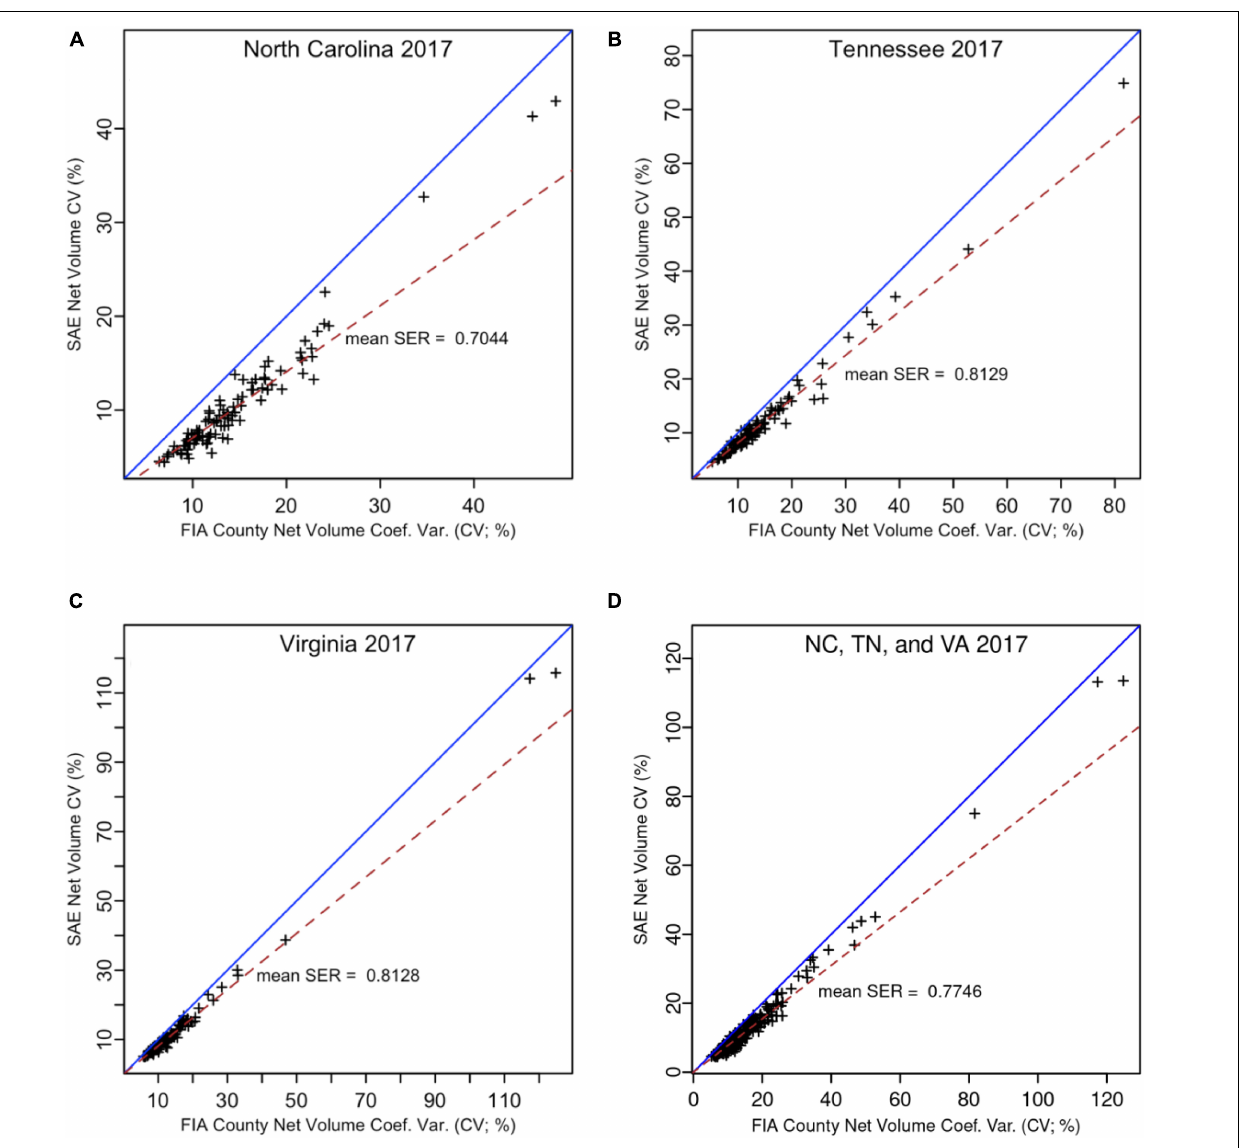
FIGURE 2 | Fay Herriot estimates RMSE% compared to FIA direct estimate standard errors (percent of county total) for three state-level analyses (A–C) and the combined 3-state analysis (D) . Non-spatial FH estimators were used for data in panels (A–C) , while the SFH estimator was used for panel (D) . (note: SER = ratio of standard